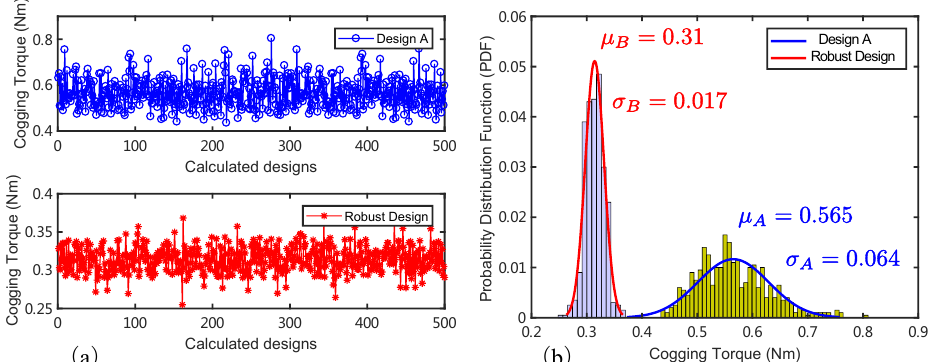
Figure 6. The cogging torque performance comparison of the initial Design A and the Robust design B, ( a ) the peak-to-peak cogging torque of 500 models featuring random uncertainties, ( b ) the probability distribution function